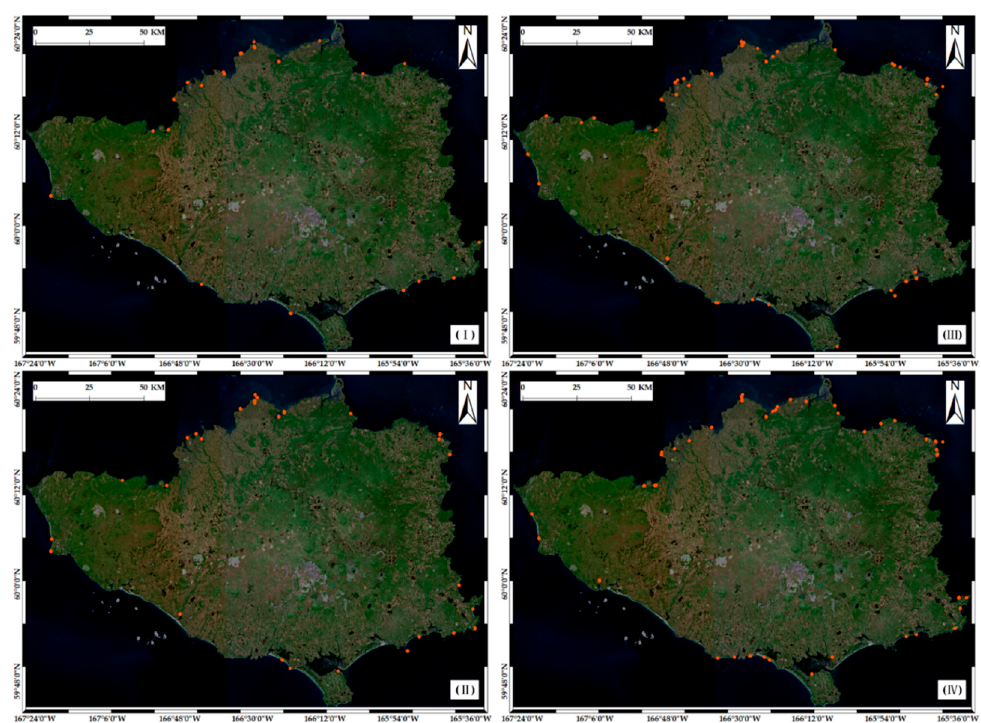
Figure 6. Detailed results of the coastal zone classification by comparison with the validation data. ( I – IV ) Coastline classification error results derived from the optimal features, all features, Sentinel-2 features, and ICESat-2 features, respectively. We only show the misclassification results in Figure 6, which are indicated in red